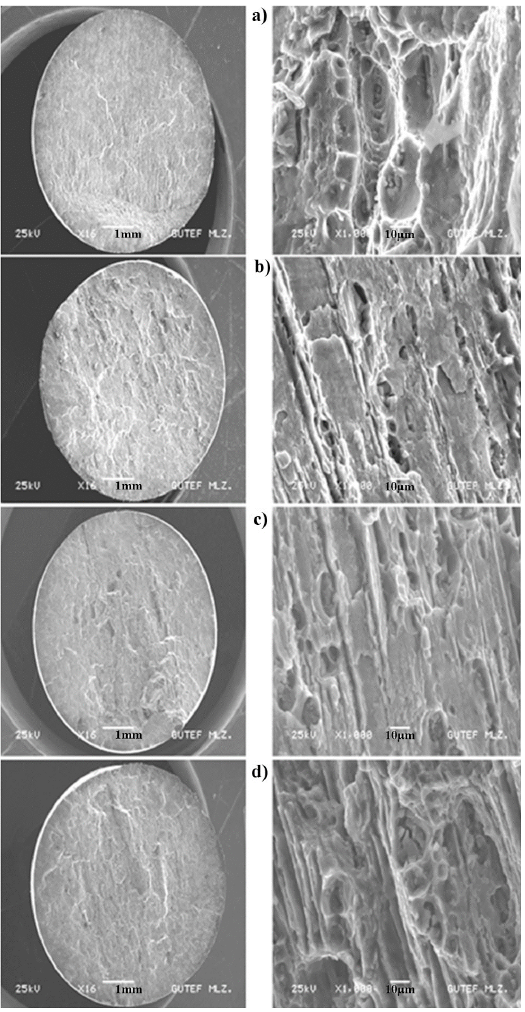
Figure 10. Fracture surface of tensile test samples; a) SHTSQ b) SHTSQ aged 140 °C for 2 h, c) SHTSQ aged 140 °C for 12h, d) SHTSQ aged 140 °C for 96 h.